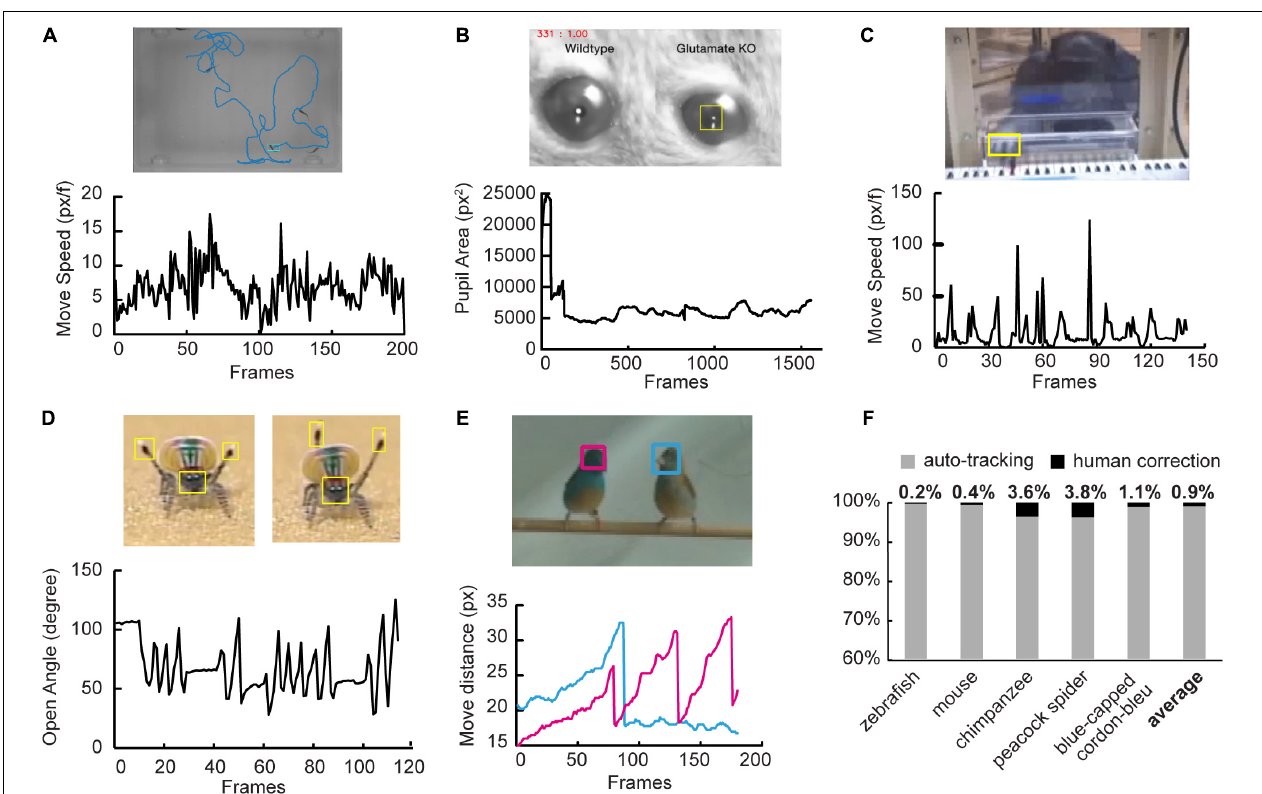
FIGURE 4 | Broader applicability of SNAP-Tracker. (A) Top: In the case of individual tracking among five zebrafish, the cyan box indicates the target fish, and the blue line shows its moving trajectory. Bottom: The plot shows the variation of swimming speed (in pixel per frame) of the zebrafish. (B) Top: In the case of mouse pupil tracking, the box shows the pupil of a glutamate knockout mouse. Bottom: The plot reveals the variation of pupil area (in pixel 2 ). (C) Top: In tracking the chimpanzee finger with complex background information, it is easy to locate the finger position accurately. Bottom: Tapping behavior can be observed in the movement speed plot (in pixel per frame). (D) Top: When analyzing the courtship behavior of a peacock spider, we tracked the tips of the pair of third legs and head. Bottom: The open angle between two third legs, a sign of the “Fan” dance, is speculated. (E) Top: In tracking two blue-capped cordon-blues, we tracked the positions of their heads with different color boxes. Bottom: The plot represents the movement of heads with corresponding colors, which exhibits the interactive bobbing behaviors of birds. (F) The bar plot shows the ratios of human correction in tasks. Percentages of human correction (black) in the five tasks are 0.2, 0.4, 3.6, 3.8, and 1.1% respectively. The average human correction is 0.9 ±